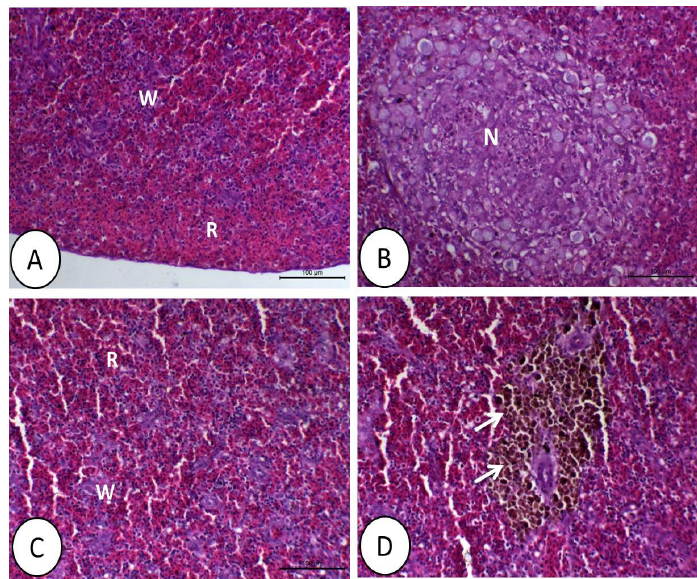
Figure 5. Histology of spleen of Nile tilapia in the control ( A ), deltamethrin (DMT) ( B ), synbiotic ( C ), and both DMT with synbiotic ( D ) groups. In A and C, the spleen consists of white (W) and red pulps (R) that increase in group ( C ). In the deltamethrin group ( B ), the splenic tissue reveals a large area of necrosis (N). In ( D ), the splenic tissue has a relatively normal structure with increased